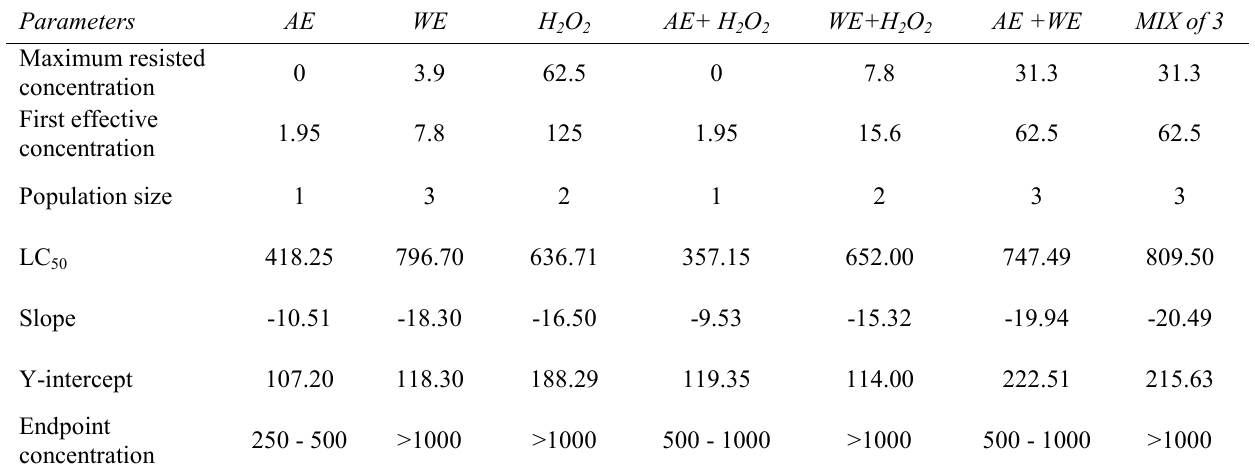
Concentrations are in B g/ml. Mix of 3 = AE+WE+H